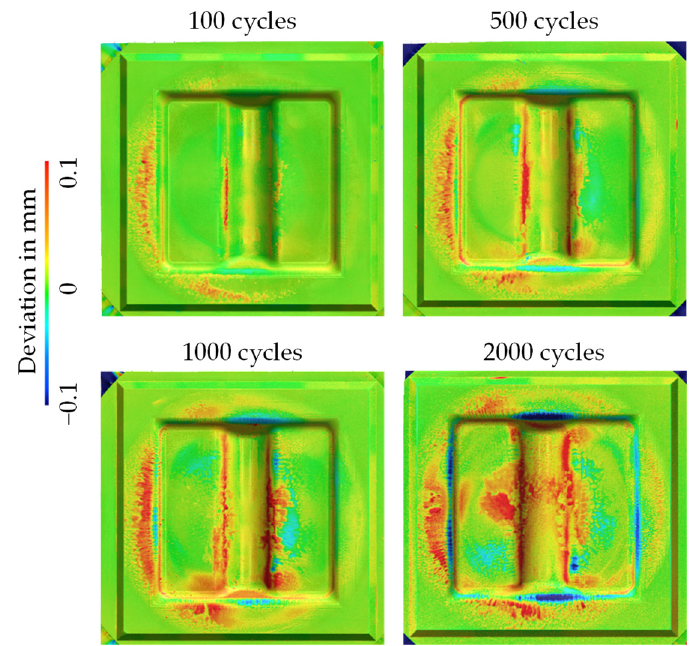
Figure 19. Surface deviation mapping of the die geometry before and after the forging tests.